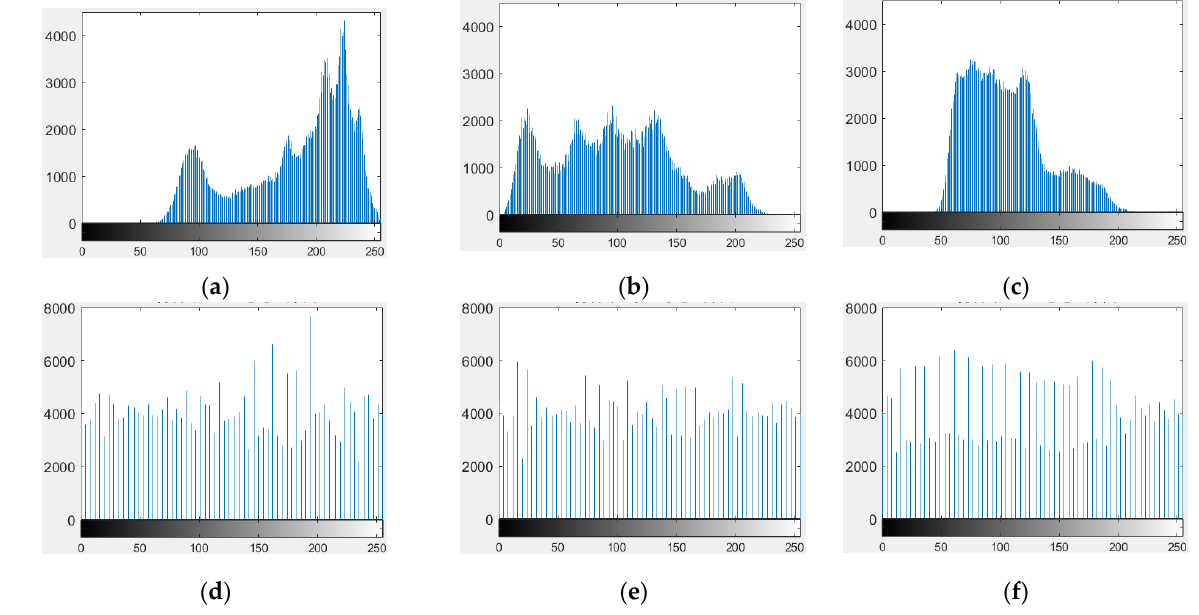
Figure 10. Histograms of original and encrypted images. ( a ) Histogram of the red channel of the original image before equalization; ( b ) Histogram of the green channel of the original image before equalization; ( c ) Histogram of the blue channel of the original image before equalization; ( d ) Histogram of the red channel of the decrypted image after equalization; ( e ) Histogram of the green channel of the decrypted image after equalization; ( f ) Histogram of the blue channel of the decrypted image after